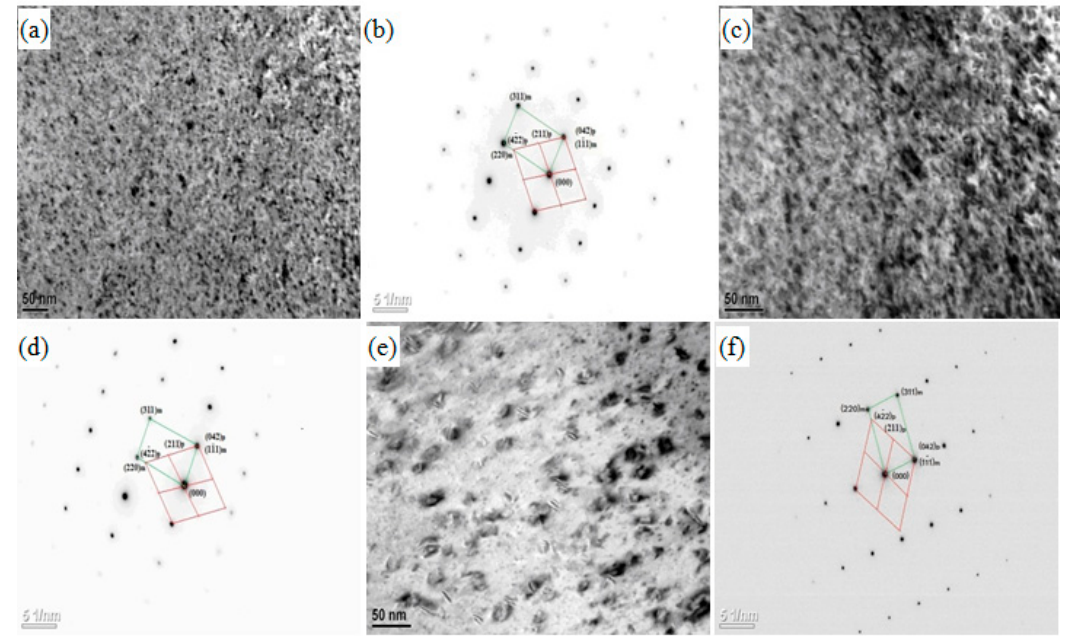
Figure 5. TEM of alloy aged at 500 °C for 1 hour with a zone axis of [ − 112] Cu : ( a ) Bright image of the S2 alloy. ( b ) SADP of ( a ) ( c ) Bright image of the S3 alloy. ( d ) SADP of ( c ) ( e ) Bright image of the S4 alloy. ( f ) SADP of ( e ).